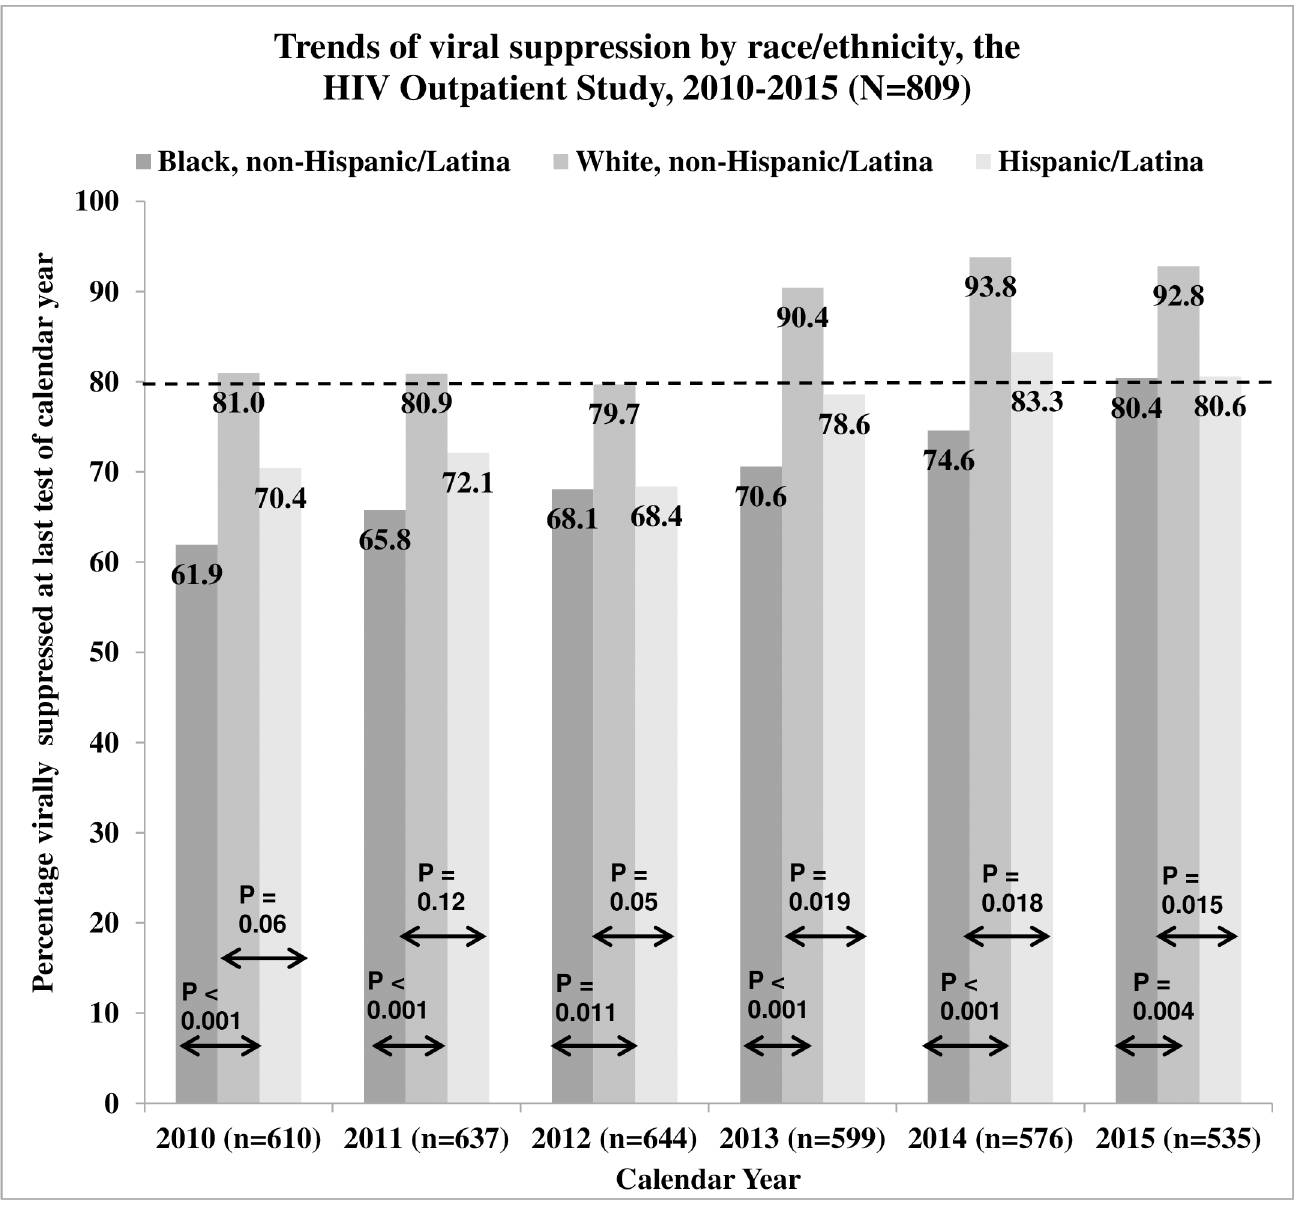
Fig 2. Trends of viral suppression among women by race/ethnicity, the HIV Outpatient Study, USA, 2010–2015 (N = 809). Proportion confidence intervals were obtained using the OpenEpi version 3.01 Mid-P Exact Method.